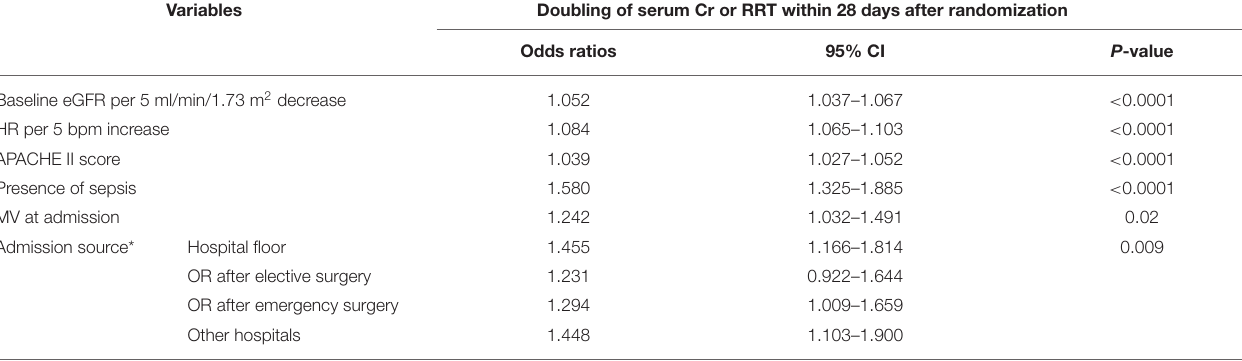
TABLE 3 | Odds ratios of independently significant predictors in the final model. Variables Doubling of serum Cr or RRT within 28 days after randomization Odds ratios 95% CI P